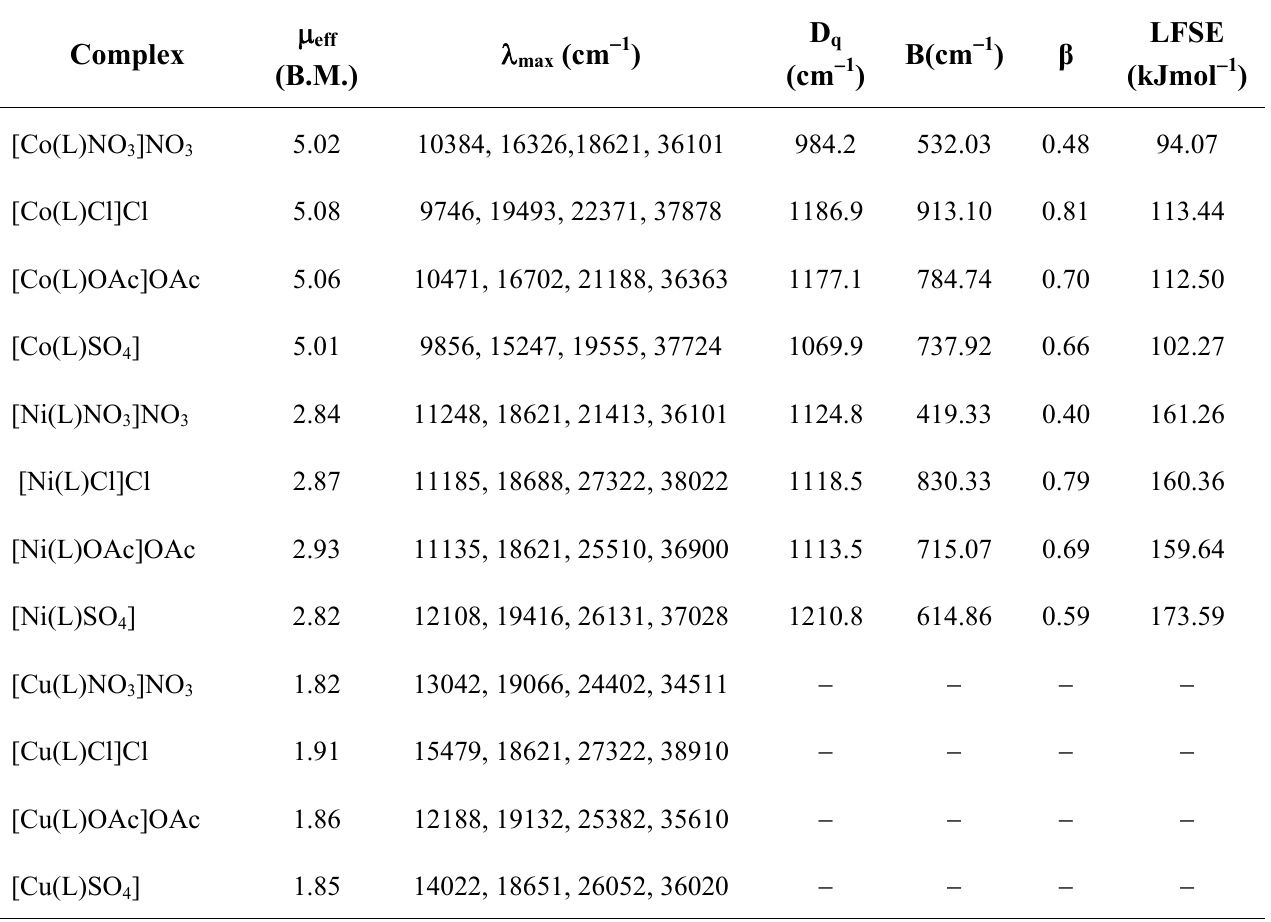
Table 4. Magnetic moment values, electronic spectral and ligand field parameters data of complexes.